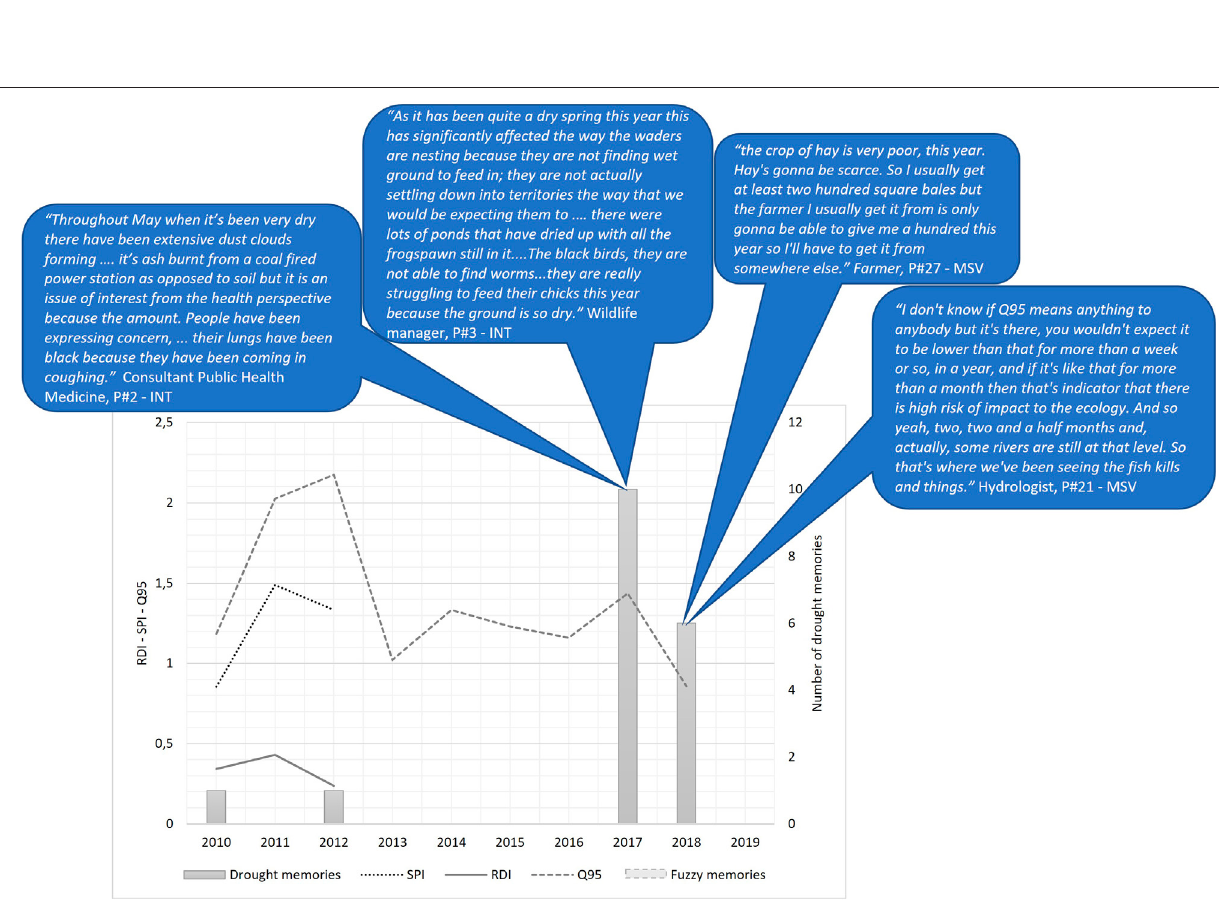
Frontiers in Environmental Science |